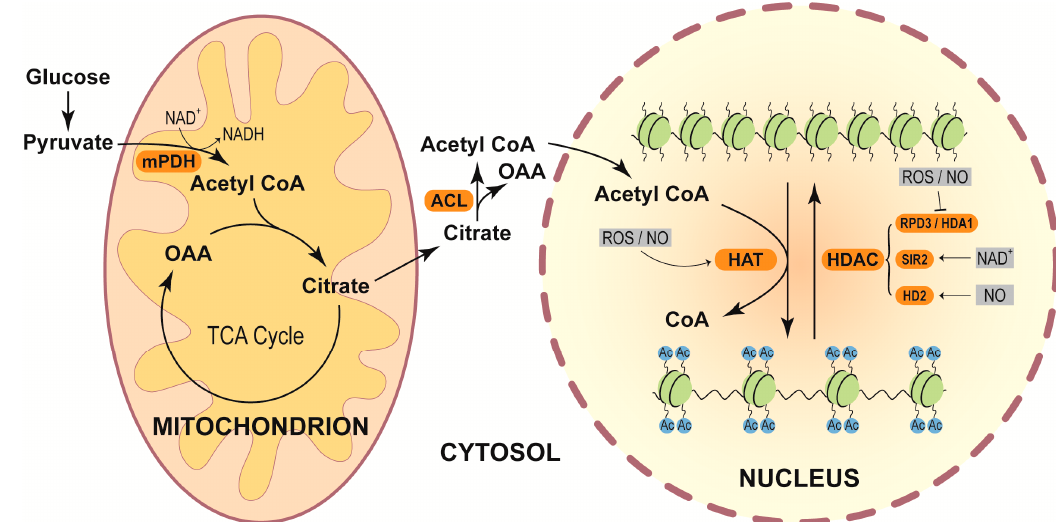
Figure 3. Redox components influence histone acetylations. In the cytoplasm, glucose is broken down to pyruvate, which enters into mitochondria, and is converted to acetyl CoA through mitochondrial pyruvate dehydrogenase (mPDH) by reducing NAD + . Acetyl CoA combines with oxaloacetate (OAA) produced in the TCA cycle to form citrate, which enters cytoplasm. In cytoplasm, citrate is converted back to OAA and acetyl CoA through ATP-citrate lyase (ACL). Acetyl CoA synthesized in the cytoplasm enters into the nucleus as the source supplier of acetyl group for the histone acetylation process. HAT utilizes the acetyl group from acetyl CoA to introduce acetylation marks (Ac) over the lysine residues of the histone tail, thus weakening the contact between DNA and histone and facilitating gene expression. HDAC removes histone acetyl group, leading to chromatin compaction. Different HAT and HDAC enzymes are affected by ROS, NO, and NAD + .